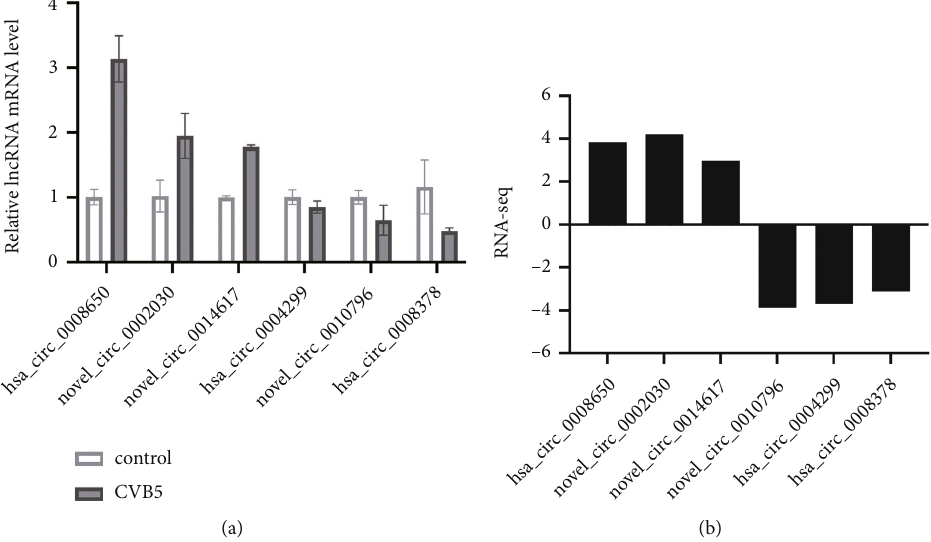
Figure 4: Validation of di ff erentially expressed circRNAs by qRT-PCR. (a) Expression levels of six circRNAs validated by qRT-PCR. (b) Expression levels of six circRNA validated by